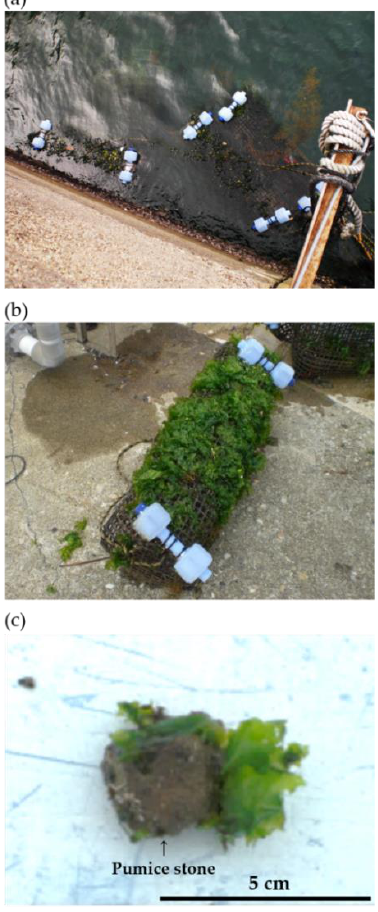
Figure 2. Pictures of artificially introduced ( a ) Ulva beds using floating cages at Stn. 1; ( b ) a landed floating cage U. pertusa is well grown; ( c ) U. pertusa grew on the pumice stone.